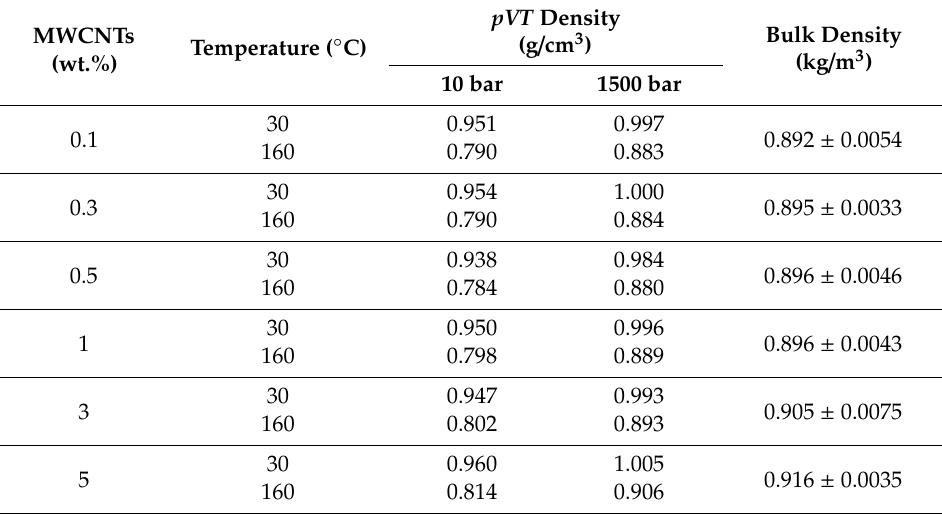
Table 4. Density of the LDPE / MWCNT composites as a function of temperature and pressure.